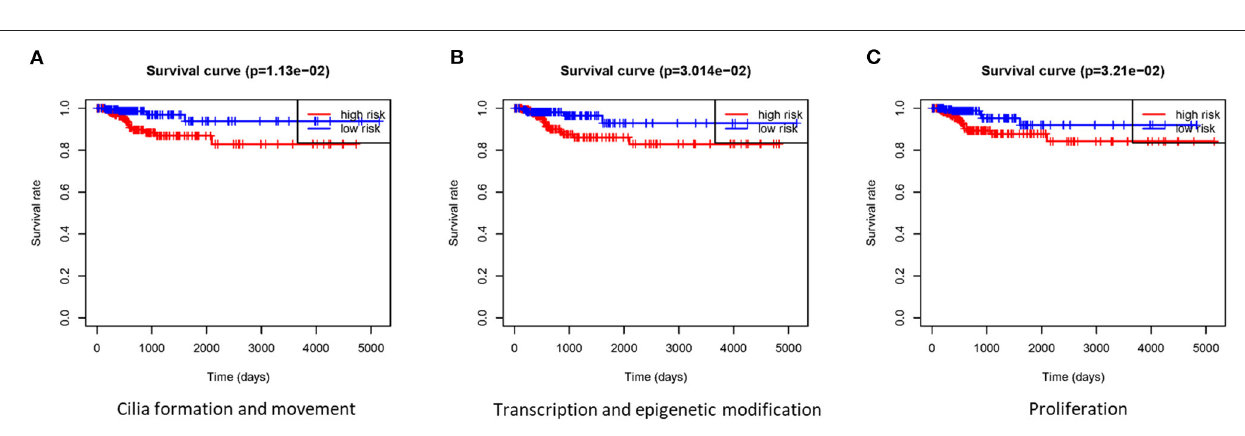
FIGURE 4 | Gene signatures were tested for DFS analyses in patients with thyroid cancer. (A–C) There were significant differences in DFS between the high-risk group and low-risk group in cilia formation and movement, transcription and epigenetic modification, and proliferation groups. DFS, disease-free